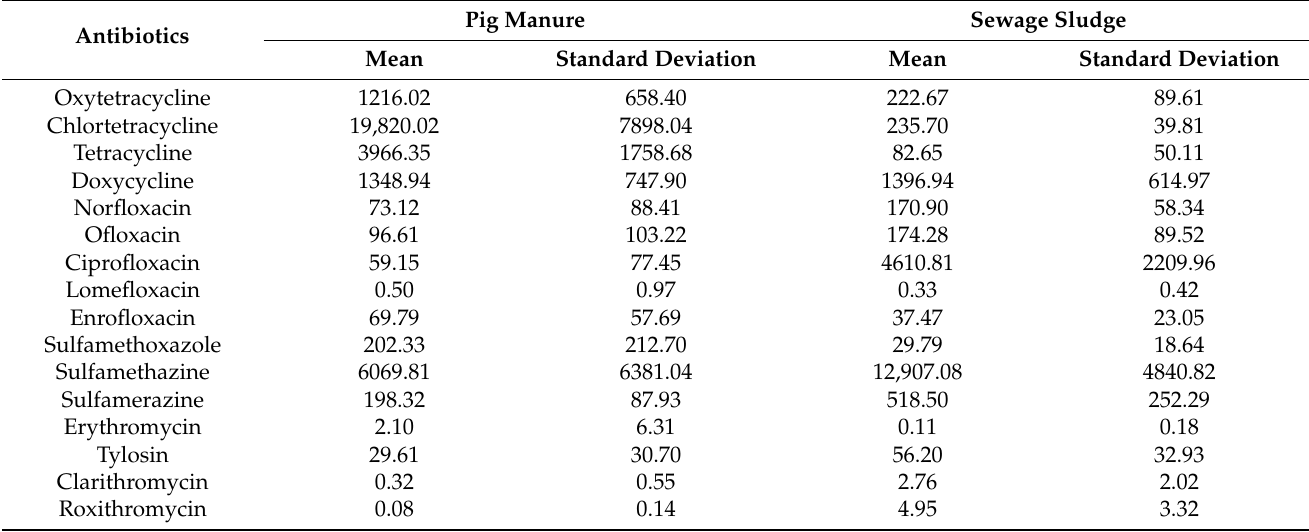
Table 3. Antibiotics in pig manure and sewage sludge (ng/g, dry